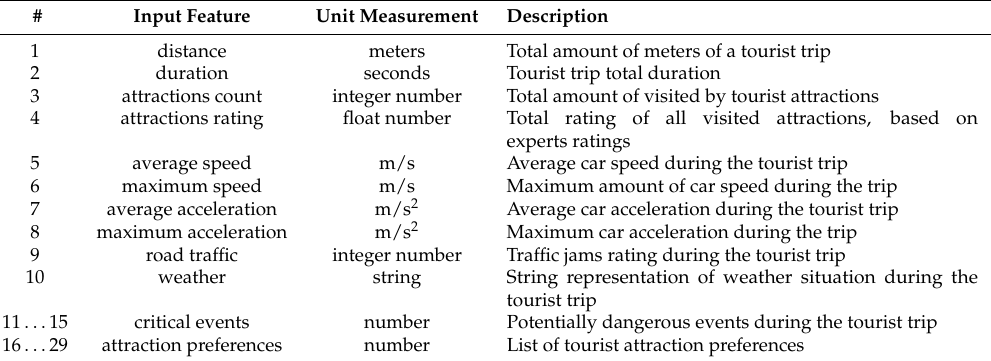
Table 2. List of the classification neural network input layer